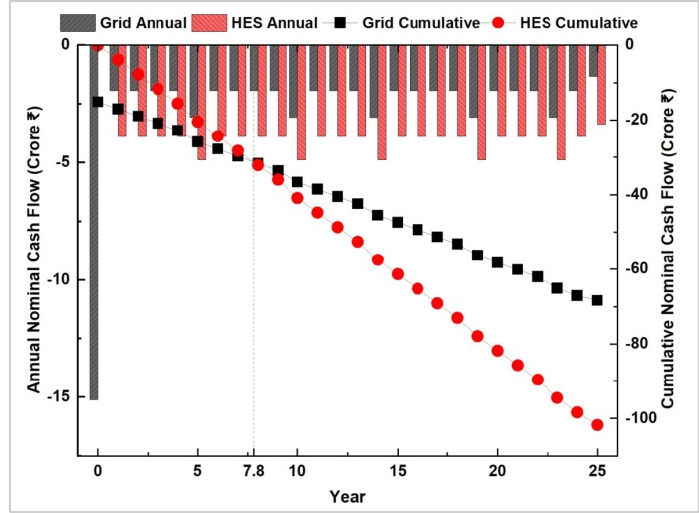
Figure 15. Comparison of annual and cumulative nominal cash flows of the proposed hybrid energy system and the existing system.